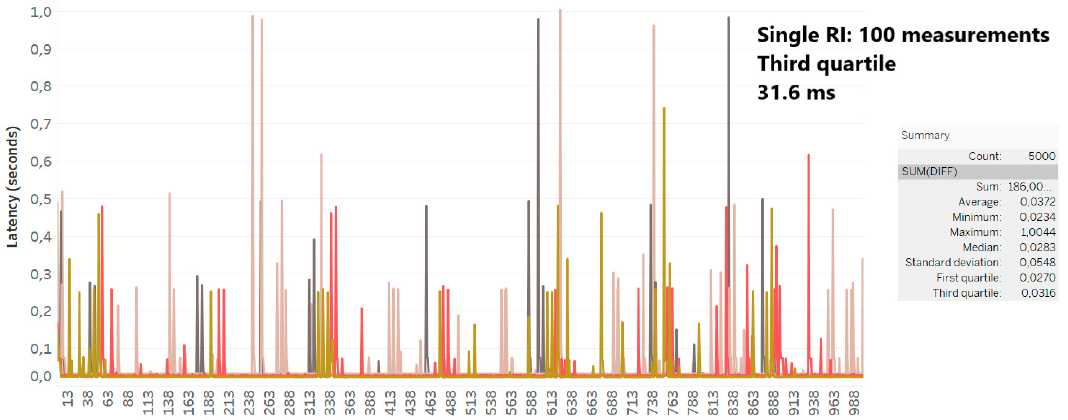
Figure 9. Single RI results for JaNDER Level 0 test: 100 measurements for every repetition.